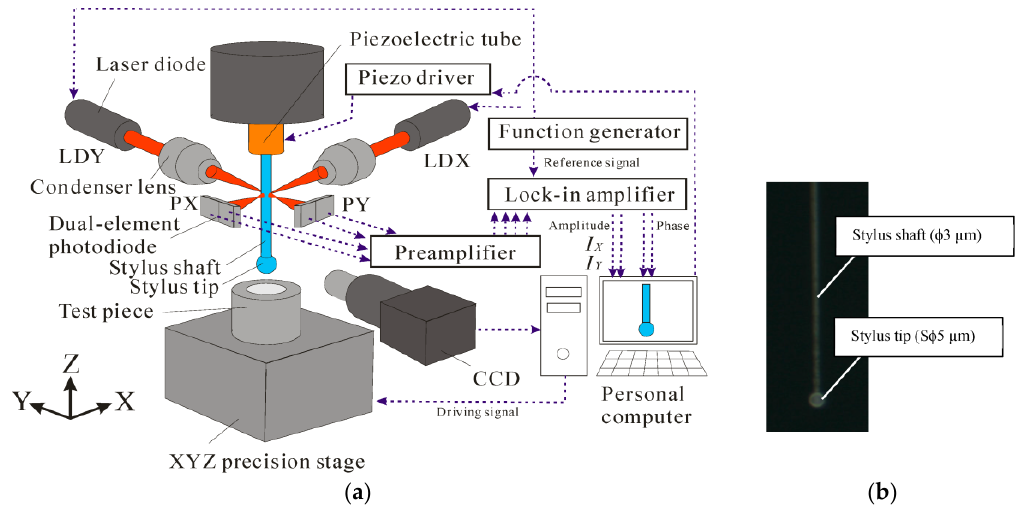
Figure 1. Measurement system using an optical fiber probe. ( a ) Schematic diagram of probing system; ( b ) Fiber stylus.